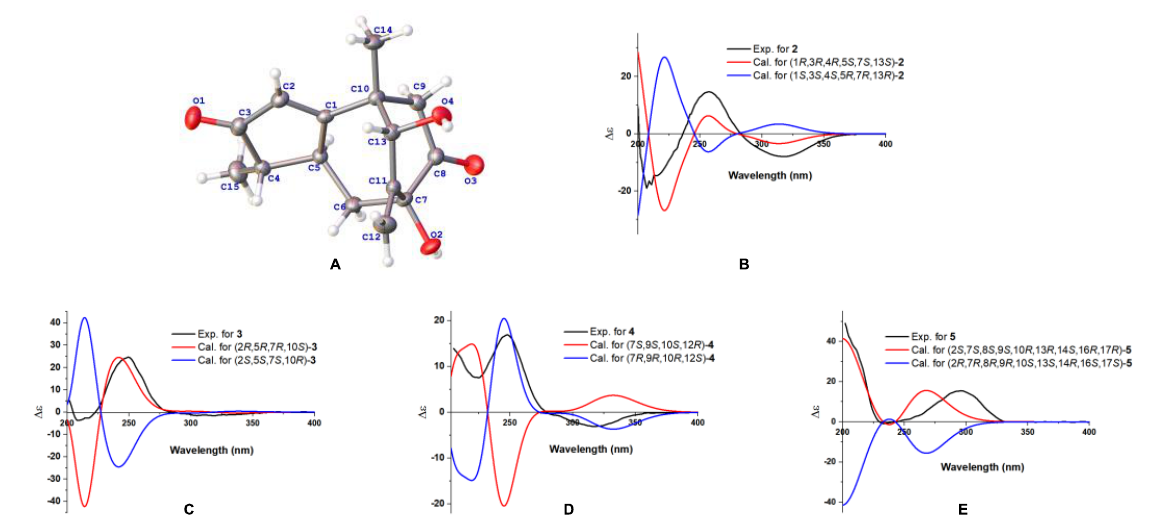
Figure 4. ( A ): X-ray structure of 1 . ( B – E ): The calculated and experimental ECD spectra of 2 – 5 . Figure 4. A: X-ray structure of 1 . B – D: The calculated and experimental ECD spectra of 2 – 5. Compound 3 was obtained as a colorless gum with positive optical rotation ([ α ] 25 D +36.4 in MeOH). The molecular formula of 3 was deduced as C 15 H 20 O 3 derived from its HRESIMS, 13 C NMR, and DEPT spectra. The 1 H NMR spectrum of 3 (Table 2) gives the signal for one methyl (0.93 (s)). The 13 C NMR and DEPT spectra (Table 2) contain 15 carbon signals classified into one methyl, five methylenes (including one terminal olefinic methylene), six methines (one olefinic, two aldehyde groups, and one aliphatic with oxygenated), and three non-protonated carbons (two olefinic). The 1H and 13C NMR spectra of 3 were very similar to those of 12,15-dioxo- α -selinen [11], except for the presence of an additional hydroxy group substituted on C-2, which was corroborated by the 1 H − 1 H COSY correlations of H-1/H-2/H-3 (Figure 2). The ROESY correlations of Hb-1, H-7/H-5 revealed that the H-5 and H-7 at C-5 and C-7 were assigned in a α -orientation (Figure 3). Meanwhile, the ROESY correlations of Ha-1, H-2/H 3 -15 indicated that H-2 and H 3 -15 are both β -oriented. To clarify the absolute configuration of 3 , the ECD calculations were utilized, which shows that the calculated ECD curve of (2 R ,5 R ,7 R ,10 S ) - 3 (Figure 4C) matches well with the calculated one, evidently indicating the absolute configuration are 2 R ,5 R ,7 R ,10 S , named as aquisinenoid